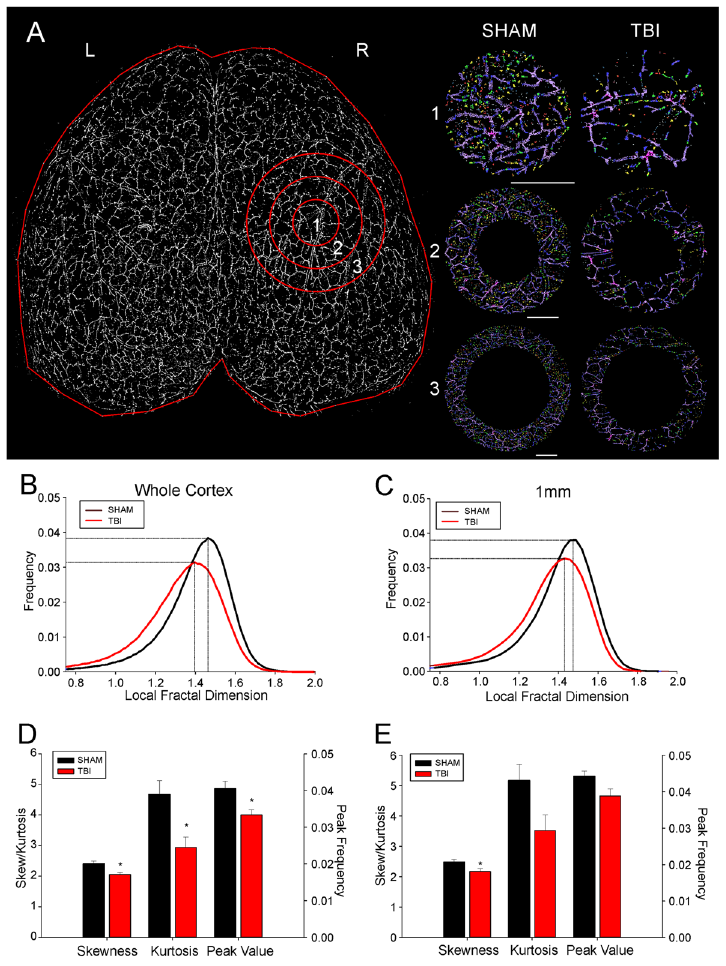
Figure 4. Fractal analysis reveals a quantitative reduction in both vascular complexity and frequency in TBI animals. ( A ) A binary image of the axial vascular network of a representative sham animal with radial ROIs radiating outward from the injury or sham surgery site (ROI1–3). The right panel illustrates the complexity changes in the vasculature from the concentric circles as you move radially outward from the injury site. These fractal images are colorized based on the resultant fractal dimension with a gradient from lower local fractal dimension (LFD) in red (less complex network) to higher LFD in purple (more complex network). ( B ) Histogram distribution of the LFD and peak frequency from the whole cortex of TBI animals reveals a decrease in complexity of the vascular network (leftward LFD shift) along with a corresponding decrease in the peak frequency value (decreased numbers). ( C ) Distribution of the LFD at the injury site (ROI 1) mimics what is observed within the whole brain analysis. At the injury site there is a reduction in the complexity of the vascular networks (leftward LFD shift) along with a concomitant decrease in amplitude of the LFD histogram signifying decreased numbers of vascular components. ( D ) Quantitative analysis of the distribution of LFD histogram from the whole cortex revealed a significant reduction in skewness (t-test, p < 0.03), kurtosis (t-test, p < 0.03) and peak value frequency (t-test, p < 0.03) in TBI animals. The significant change in skewness and kurtosis quantitates the degree to which the complexity of vasculature has been simplified (reduced skewness) and diminished (reduced kurtosis). The peak frequency value synthesizes information on the vascular network and its relative complexity. ( E ) Quantitative analysis of the distribution of LFD at the injury site (ROI 1) reveals similar finding as seen from whole cortex analysis. Significant differences between TBI and sham animals were found only in skewness (t-test, p < 0.05) and not kurtosis or peak frequency values (t-test, p <